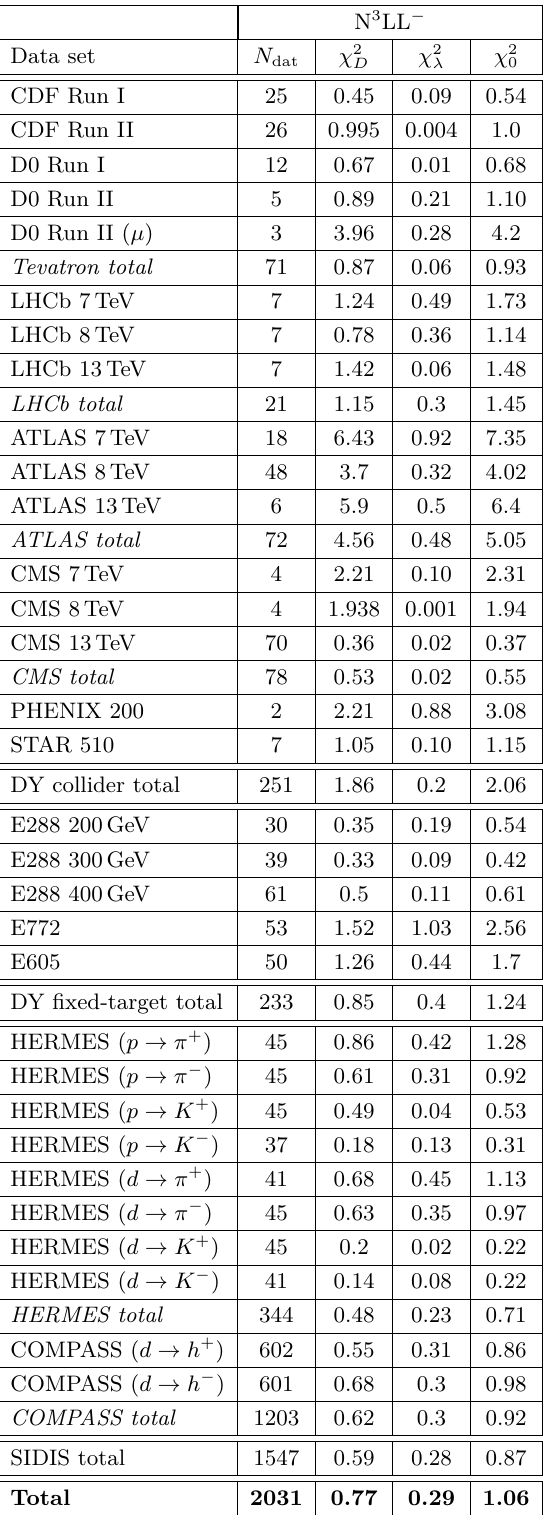
Table 4 . Breakdown of the values of χ 2 normalized to the number of data points N dat that survive the kinematic cuts for all datasets considered in our baseline fit. The χ 2 uncertainties, χ 2 is the penalty term due to correlated uncertainties (see eq. (4.1)), χ 2 λ of χ 2 and χ 2 . All χ 2 values refer to the central replica (see D λ